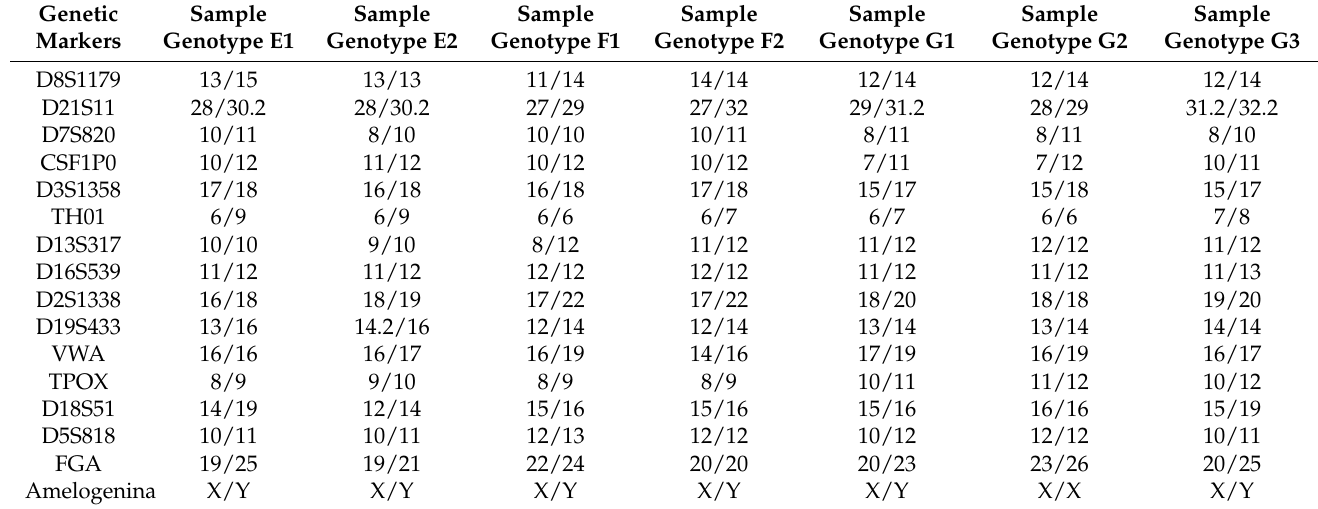
Table 3. Autosomal DNA chromosome polymorphisms results.